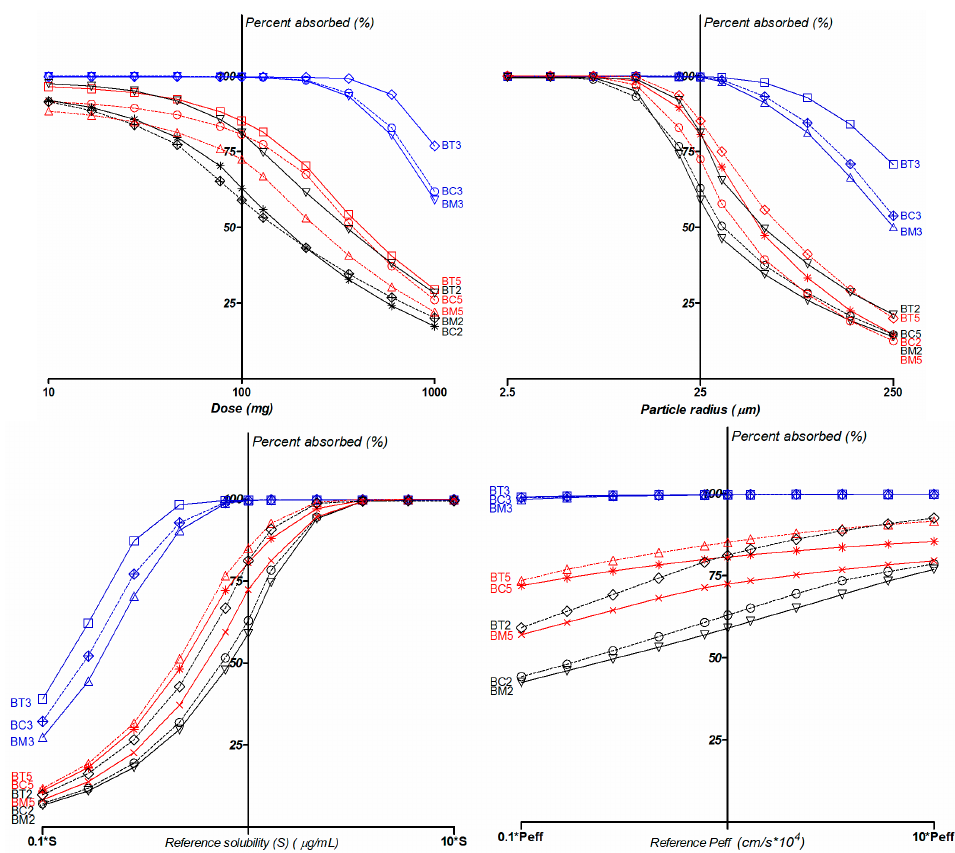
Figure 11. PSA analysis for dose, solubility at reference pH, particle radius and effective human jejunal permeability